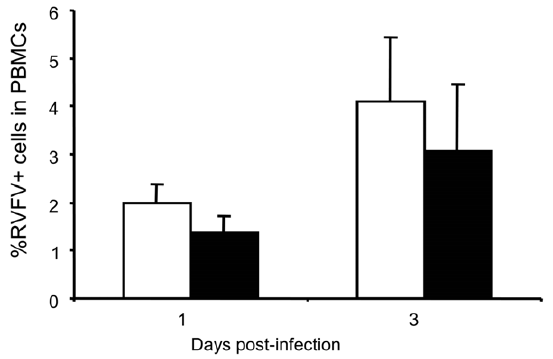
Figure 4. Virus yield from goat monocyte-derived dendritic cells (MoDCs) inoculated with RVFV. MoDCs were infected with insect cell-derived RVFV (IN-RVFV) or mammalian cell –derived RVFV (MAM-RVFV) and after 24 h, the virus in supernatants was quantified by plaque assay. Histograms represent means + standard